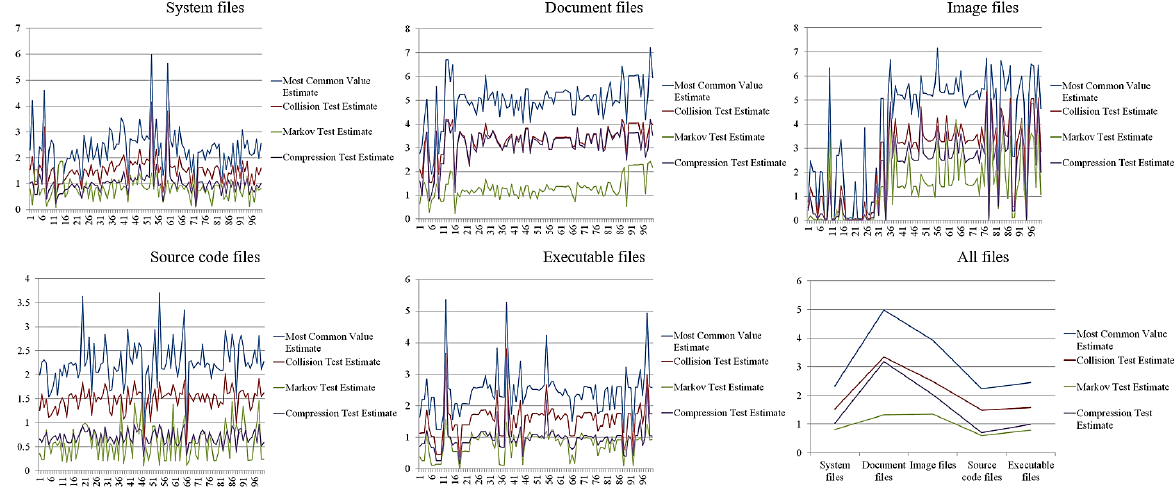
Figure 5. Entropy estimation results for 100 clean files per file